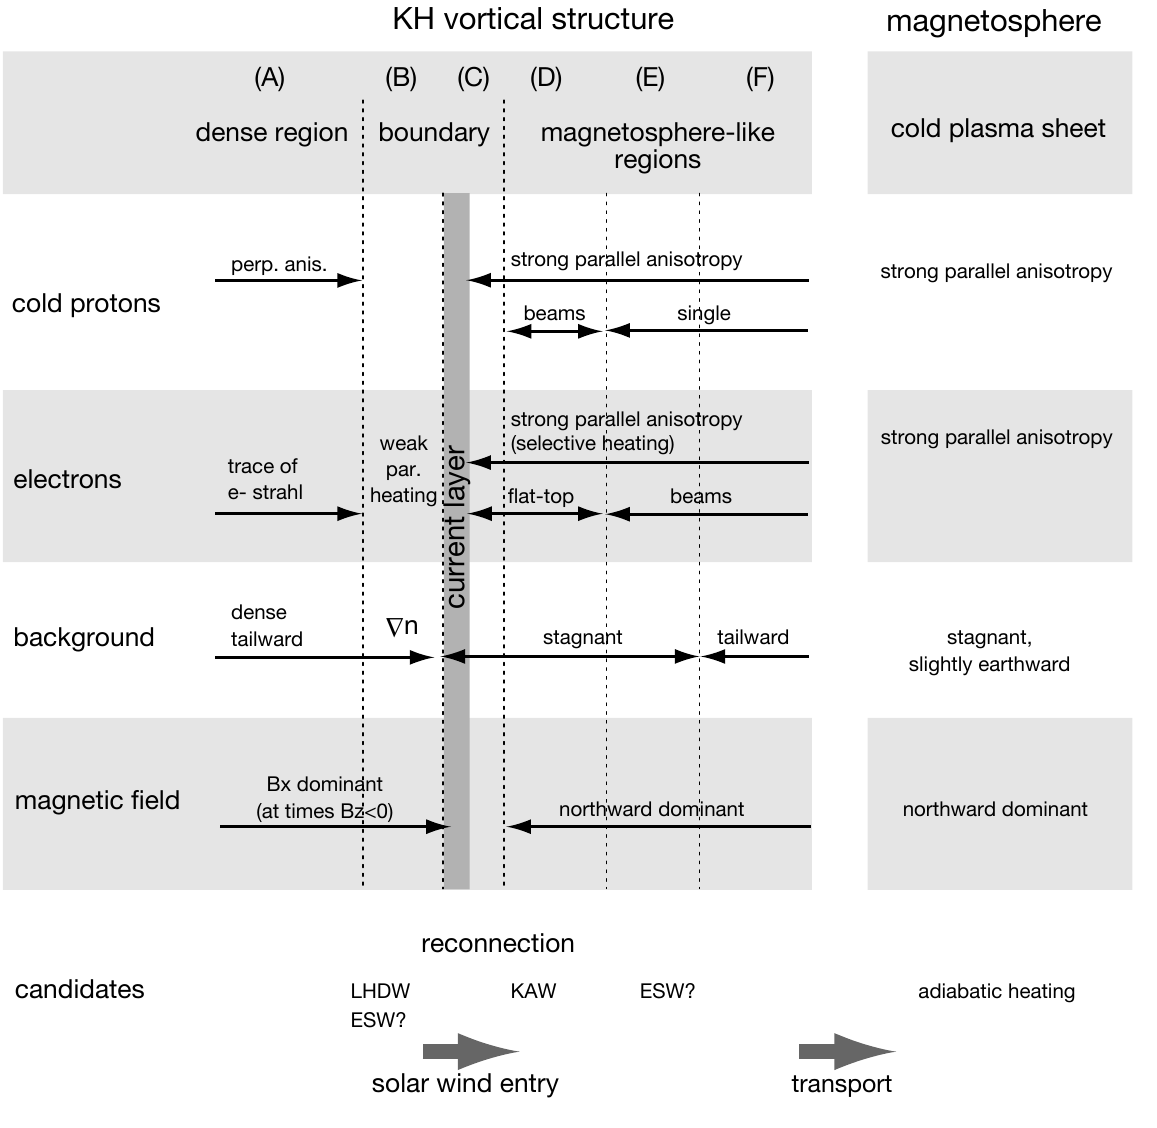
Fig. 12. Summary of observations and implicated candidates for physical